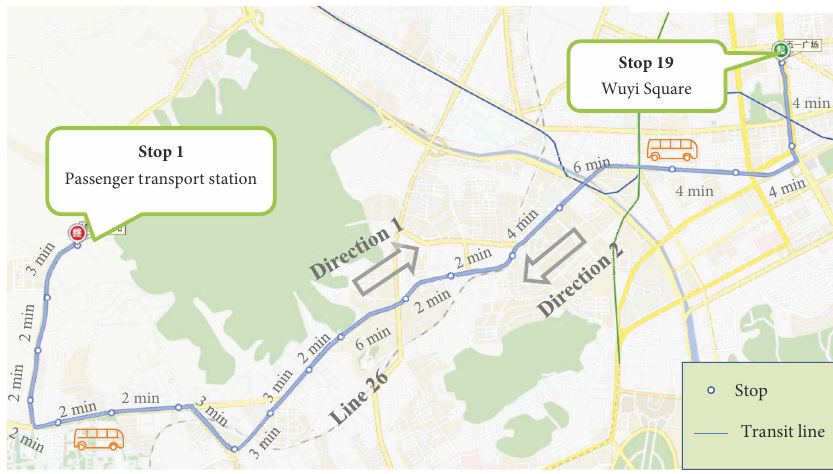
Figure 5. A real life transit route – line 26 in